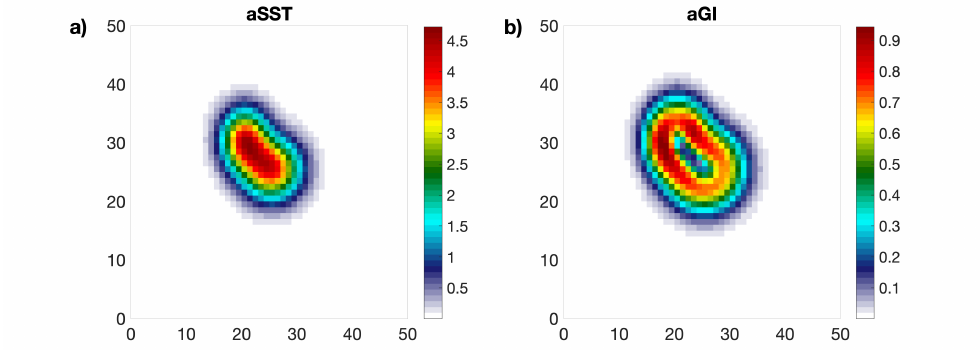
Figure 10. ( a ) Analytical SST field (aSST, in K); ( b ) analytical SST gradient intensity (aGI, in